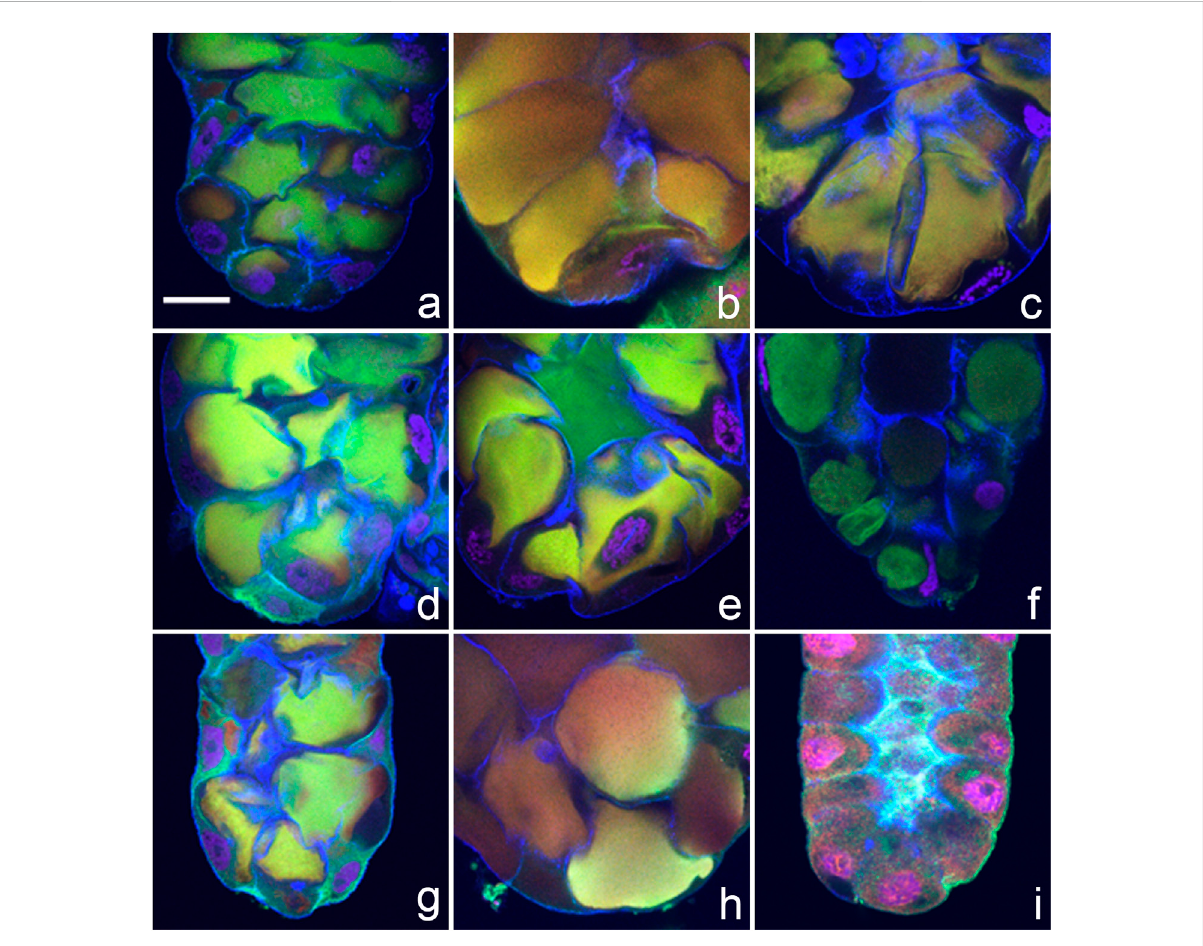
FIGURE 3 Pre-apocrine collector sacculae are present in the prepupal SGs of eight species of Drosophila . (A) D. sulfurigaster , (B) D. immigrans , (C) D. albomicans , (D) D. eugracilis , (E) D. birchii , (F) D. busckii , (G) D. mojavensis , and (H) D. virilis . In D. albomicans , the fi nal phases of sacculae contents release are slower, and some signal associated with secreted proteins can be still detected in the lumen, even after the gland itself has attained its previous smaller size (I) . The following proteins were detected in all species: red = transcription factor Broad-Complex, green = cytosolic